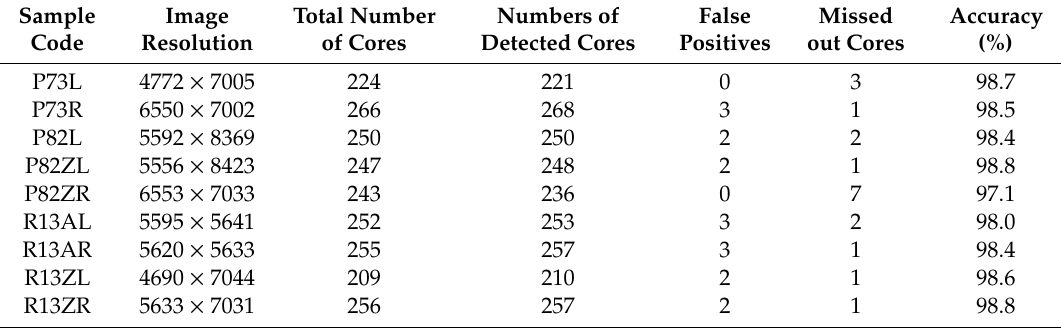
Table 1. Evaluation of DenMap for a data set of samples of CMSX-4 ® . The first three letter-number combination indicates the sample code and the last letters indicate the batch